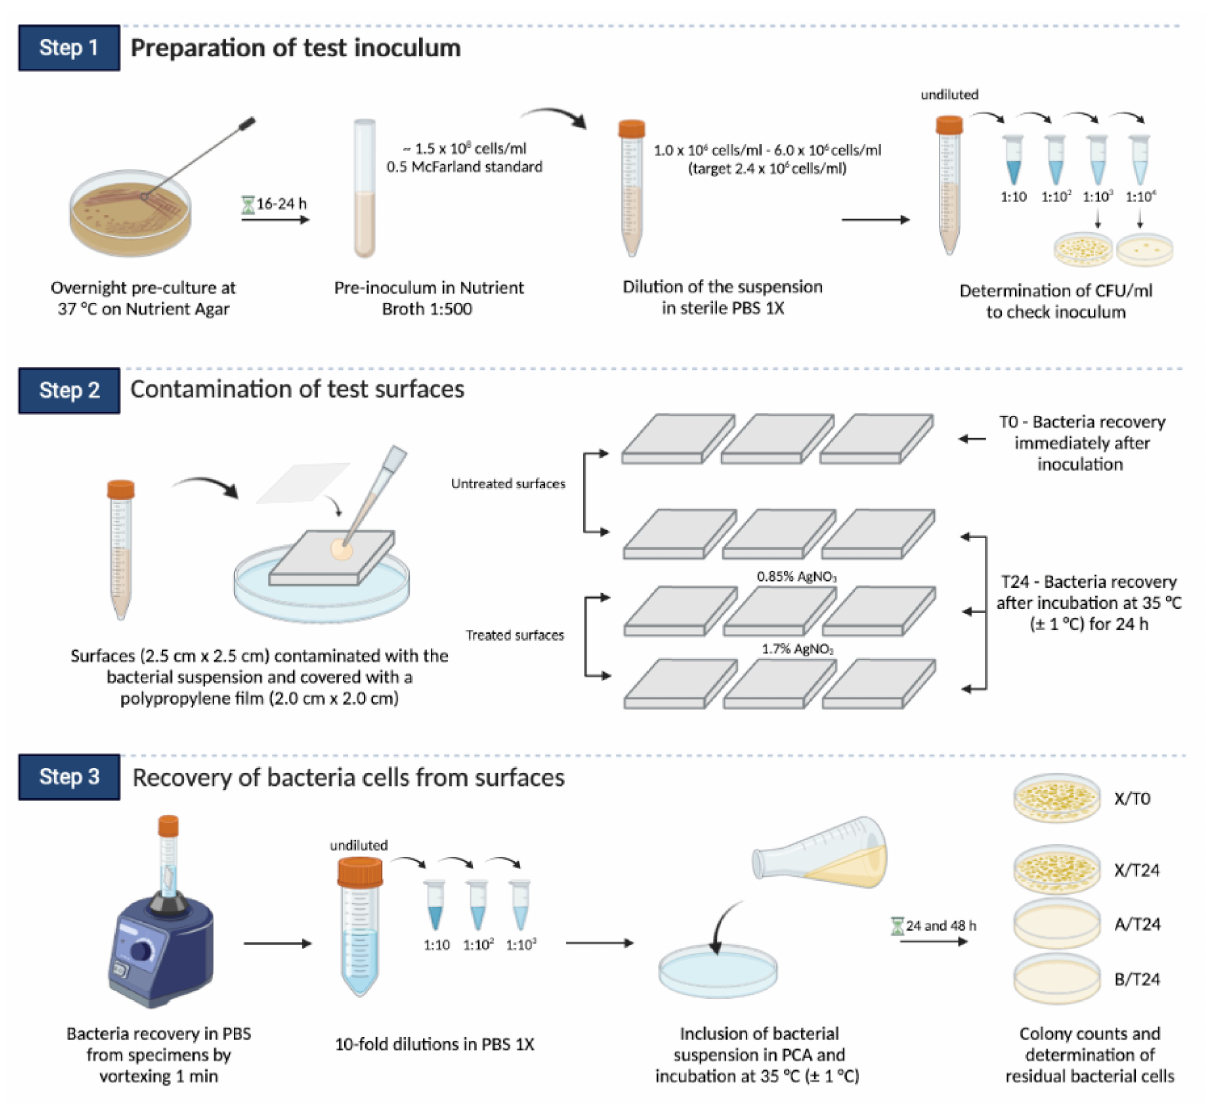
Figure 1. Graphical representation of the protocol used to evaluate the antibacterial activity of the treated specimens. CFU, Colony-Forming Units; PBS; Phosphate-Buffered Saline; PCA, Plate Count